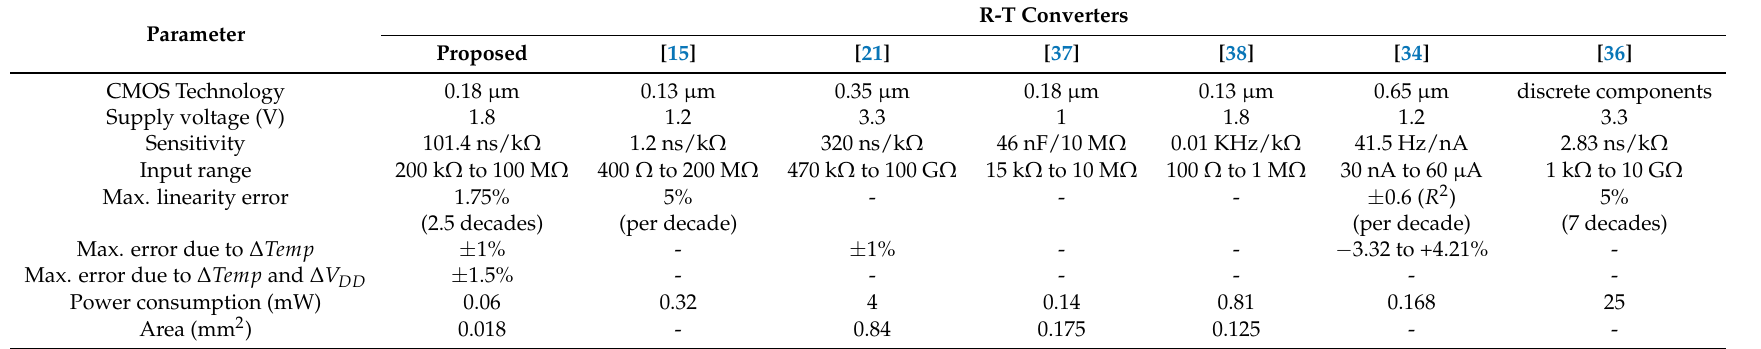
Table 3. Performance summary and